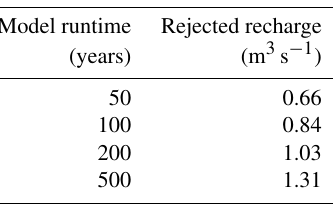
Table B1. Volumes of rejected recharge in the Mataura catchment, Southland, New Zealand, for different model